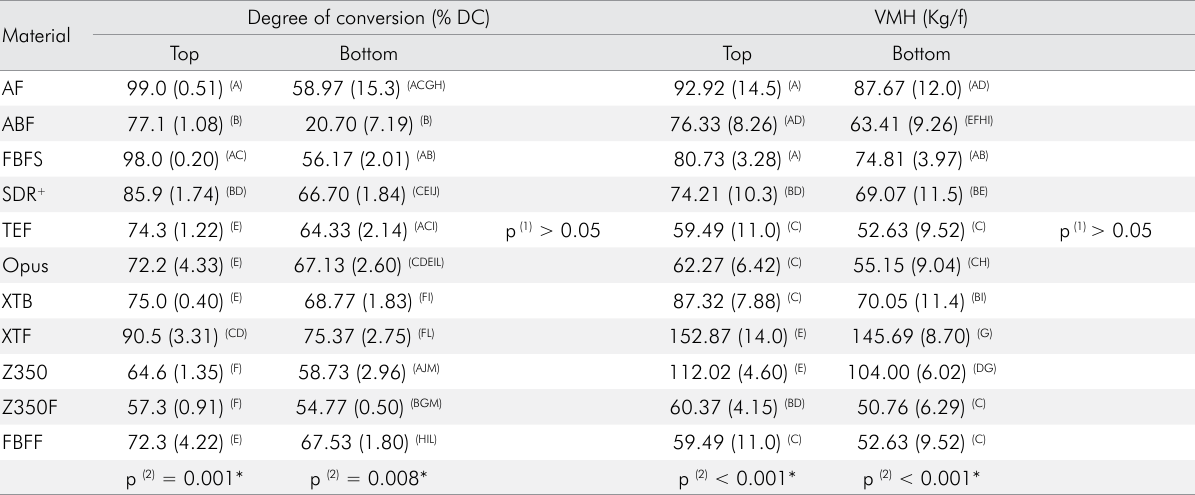
Table 2. Mean ± standard deviation of the degree of conversion and Vickers microhardness according to the material and to the polymerization side of the